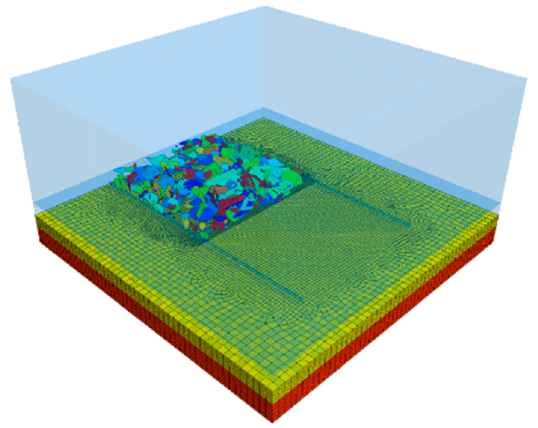
Figure 16. Numerical model with hydraulic fractures. Table 4. The designed modeling schemes.